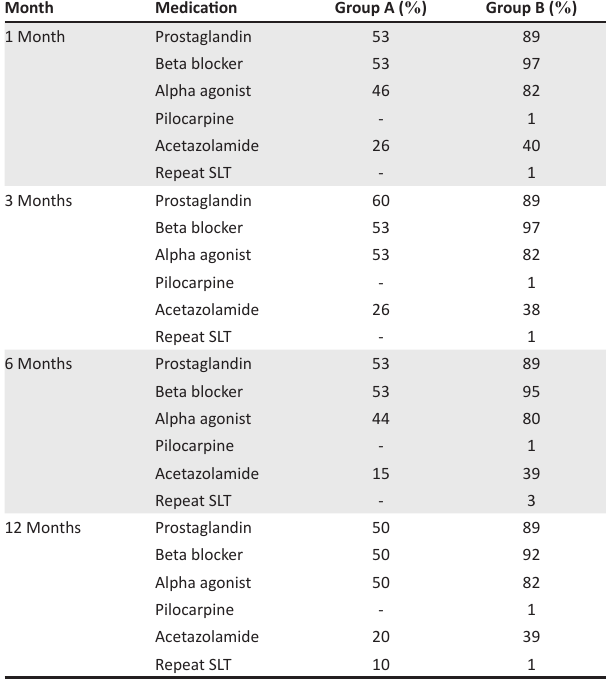
TABLE 4: Additional therapy needed after selective laser trabeculoplasty in Group A versus Group